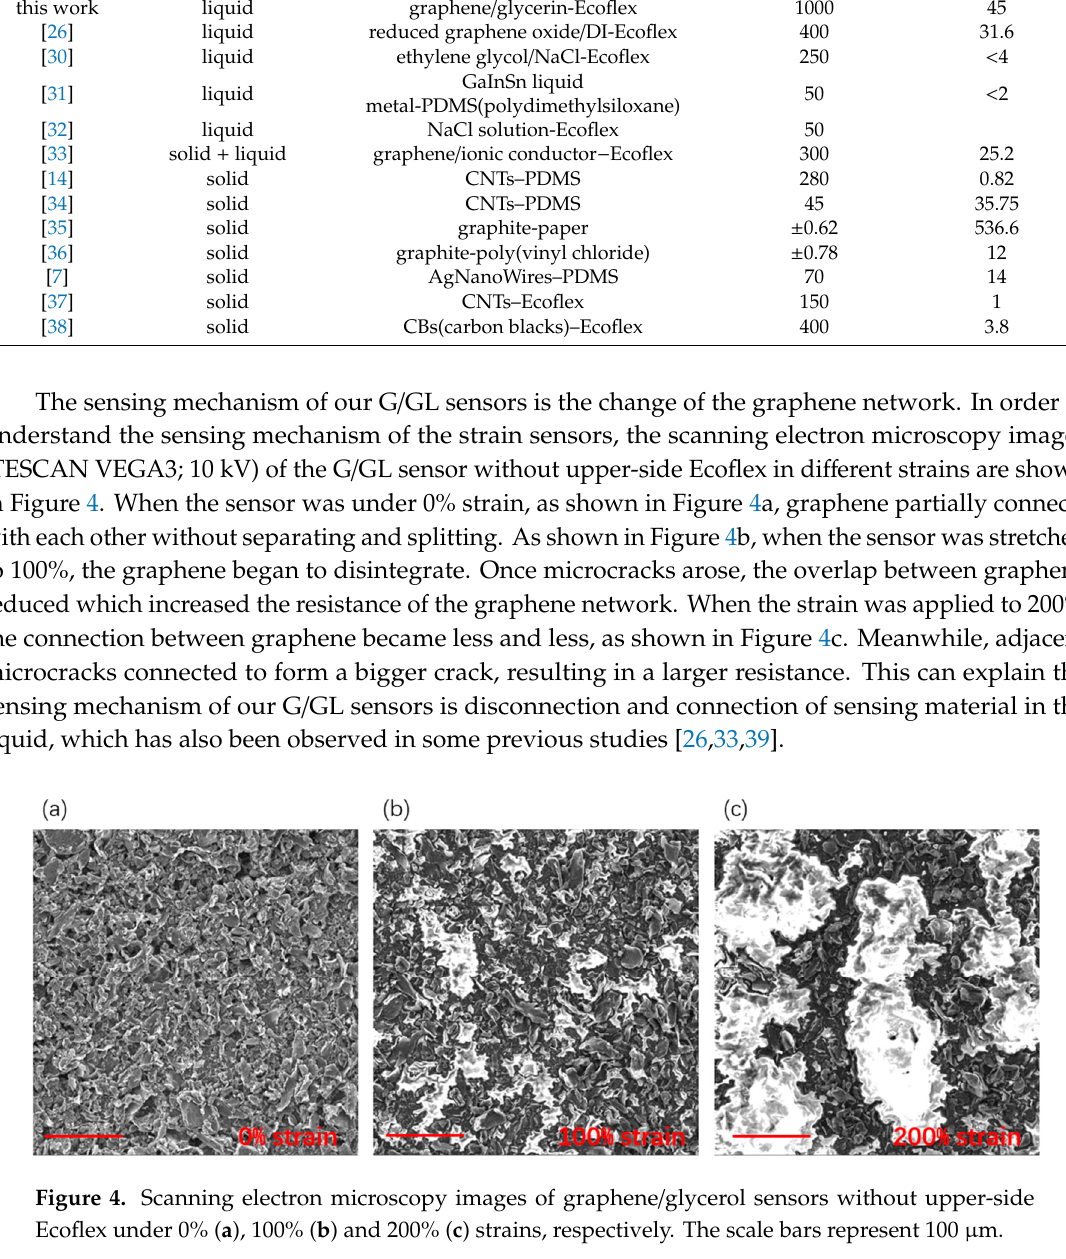
Table 1. Summary of performance results of recently reported stretchable strain sensors based on graphene or liquid conductors.